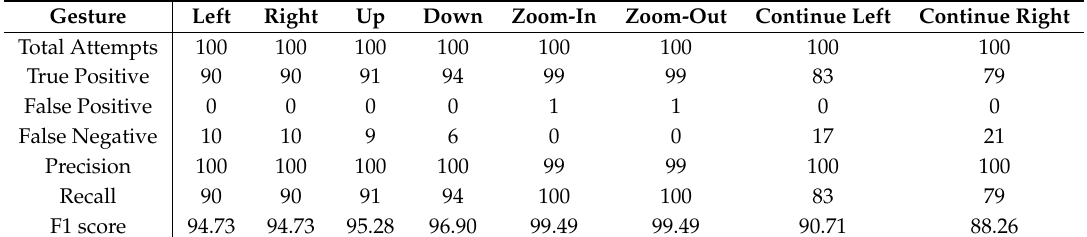
Table 3. Experiment results of precision error, recall error, and F1 score about each gesture of 10 subjects at 60–70 cm.